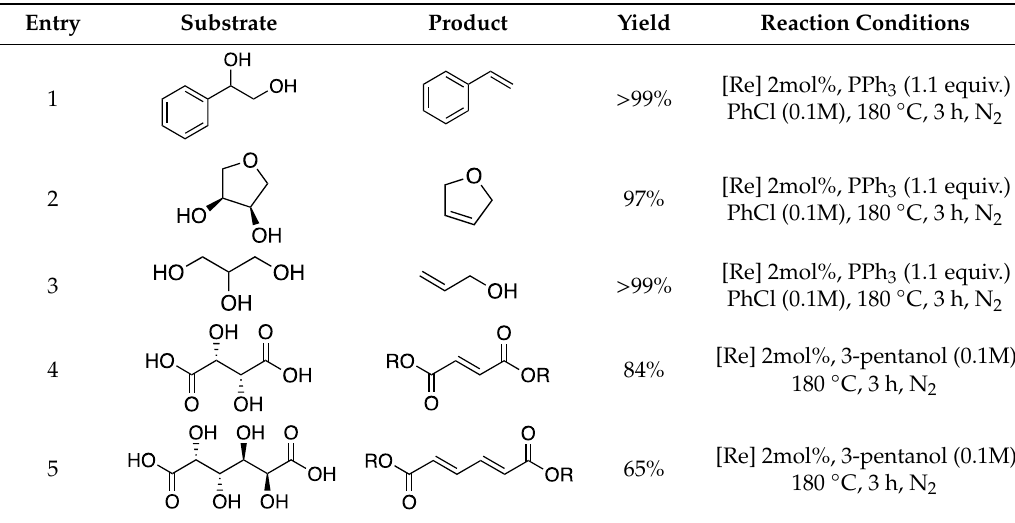
Table 5. trans -[(Py 4 )ReO 2 ]PF 6 catalyzed deoxydehydration [a].